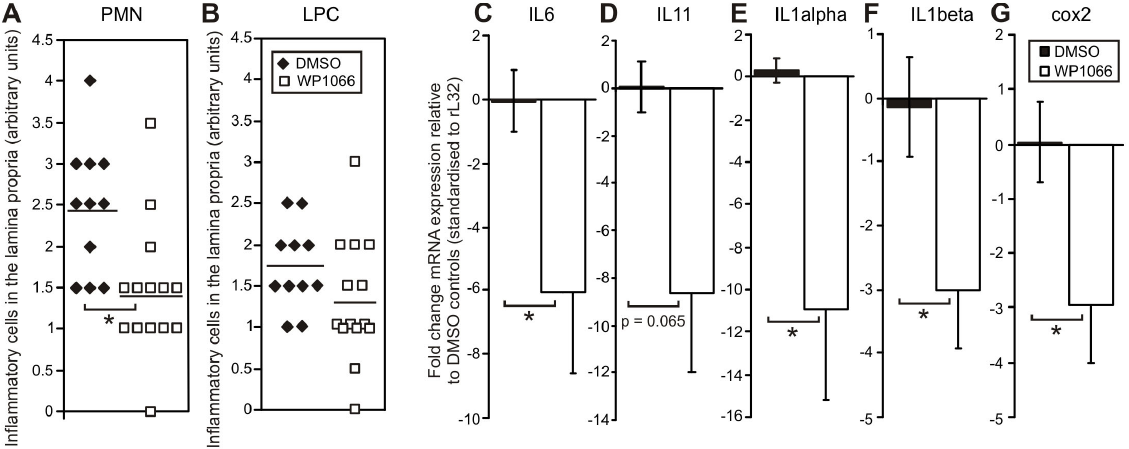
Figure 5. WP1066 treatment of gp130 757FF mice inhibits the pro-inflammatory response in the antral mucosa. gp130 757FF mice (8 weeks old) treated as for Fig. 3, had antral stomach tissue taken for histology and pro-inflammatory gene expression by Q-PCR after mRNA extraction. Treatment of gp130 757FF mice with WP1066 caused a significant reduction (p , 0.05) in polymorphonuclear infiltrate (A) in the antral stomach, but lymphoplaysmocytic infiltrate was unchanged (B). Gene expression relative to the housekeeper GAPDH for IL-6 (C), IL-11 (D), IL-1 a (E), IL-1 b (F) and COX-2 (G), was quantified by the DD CT method. All n=8; *p , 0.05 compared to DMSO controls.